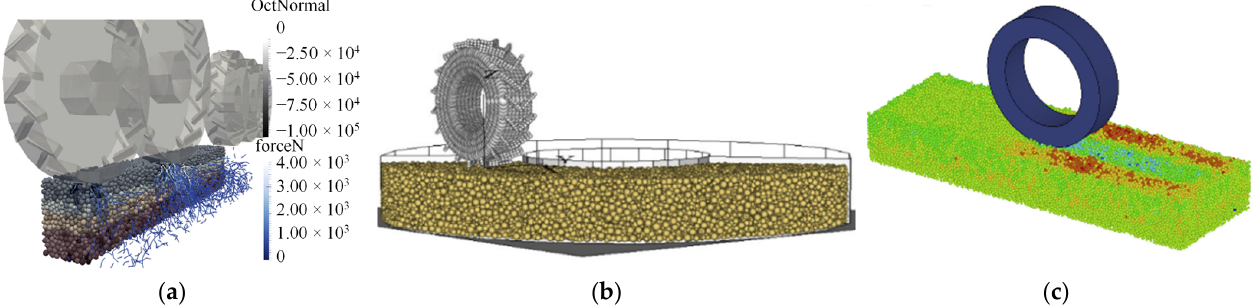
Figure 7. Three typical soil compression modeling methods. ( a ) Preinstall stress in the model [154]; ( b ) Particle agglomerate method [155]; ( c ) CFD–DEM coupling method [156].